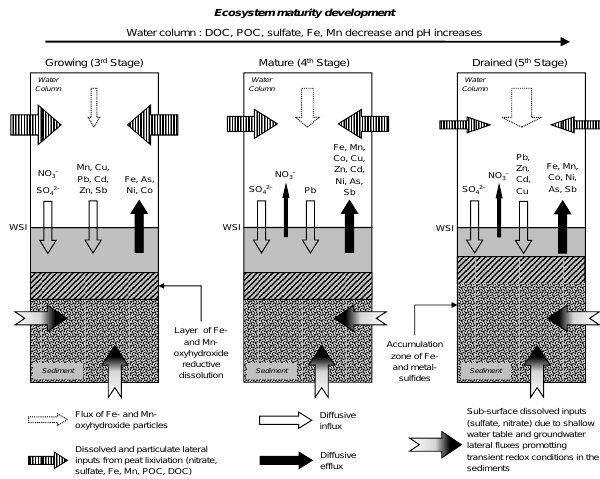
Fig. 9. Schematic conceptual model of early diagenesis-related pro- cesses and associated post-depositional redistribution of trace met- als and metalloids during the thermokarst lake maturity develop-